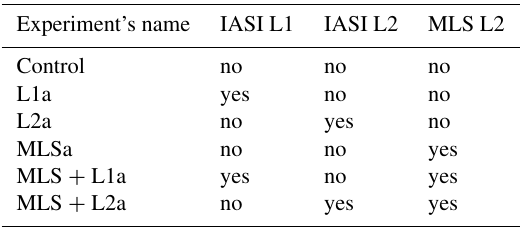
Table 3. Names of experiments and assimilated